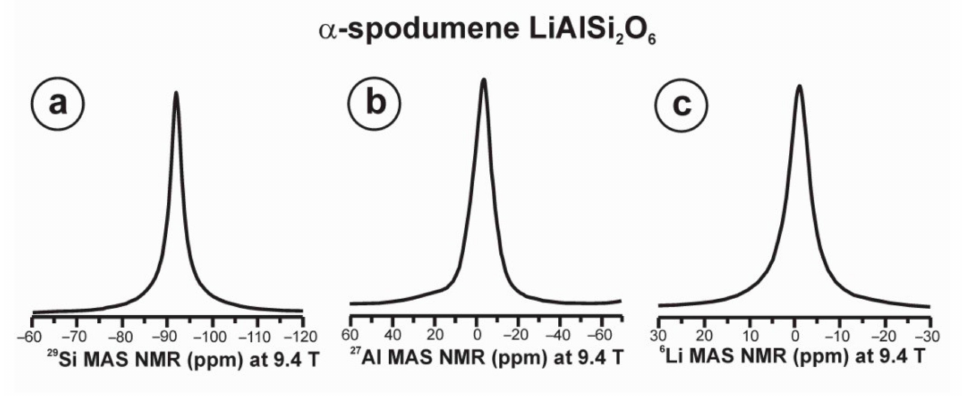
Figure 10. The 29 Si ( a ), 27 Al ( b ) and 7 Li ( c ) MAS NMR spectra of α -spodumene in specimen Golconda